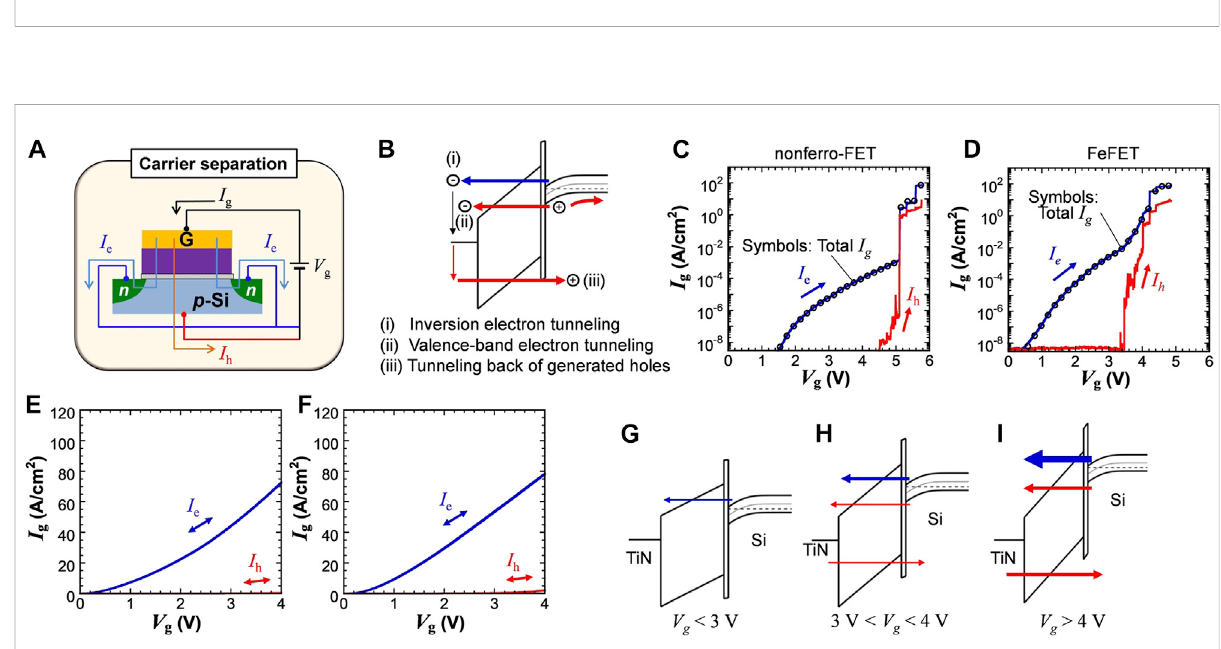
Characteristics of I g , I d , I s , and I sub for (A) HfO 2 non-ferro-FET and (B) HZO FeFET with L / W = 10/100 μ m. I g of a HZO FeFET is around 10 3 times higher than that of a HfO 2 non-ferro-FET. Steeply increasing substrate current I sub can be found in FeFETs. (C) Leakage current path in ferroelectric HZO gate insulator.